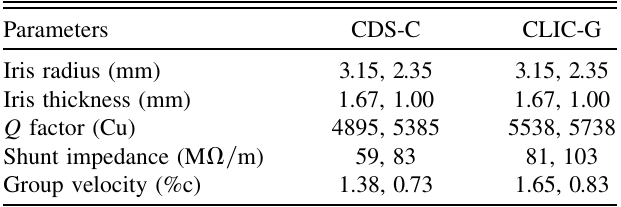
TABLE III. The rf parameters of the first and the last cell of CDS-C and